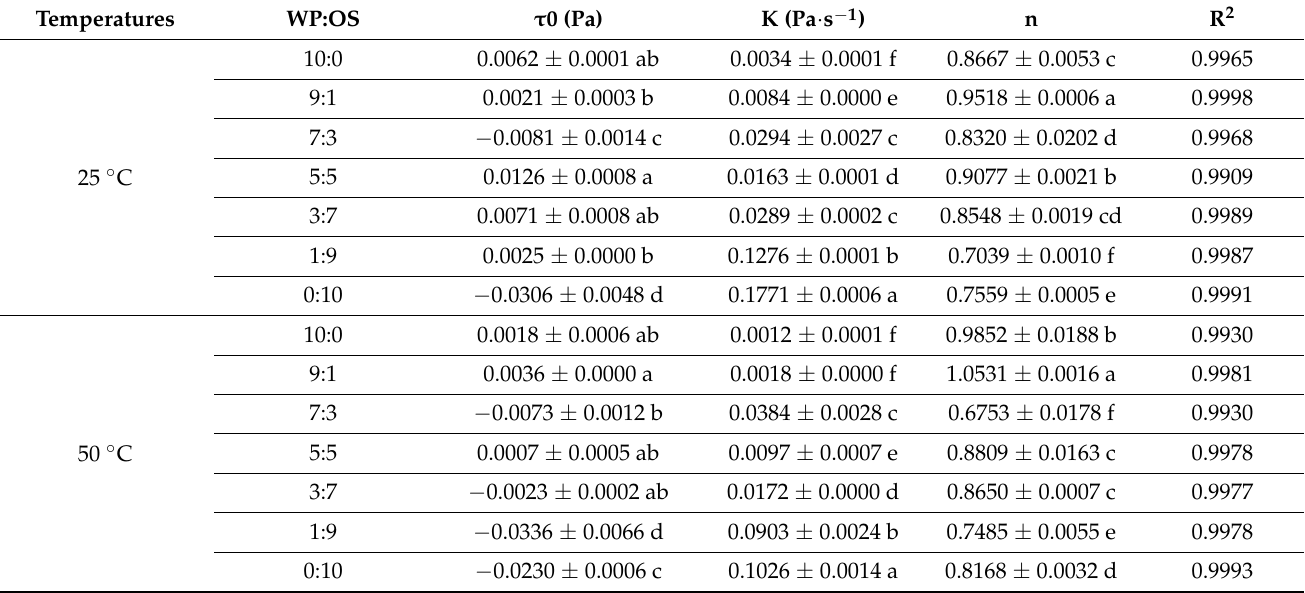
Table 1. Fitting parameters of Herschel–Bulkley equation for WP-OS-capsaicin emulsion a,b